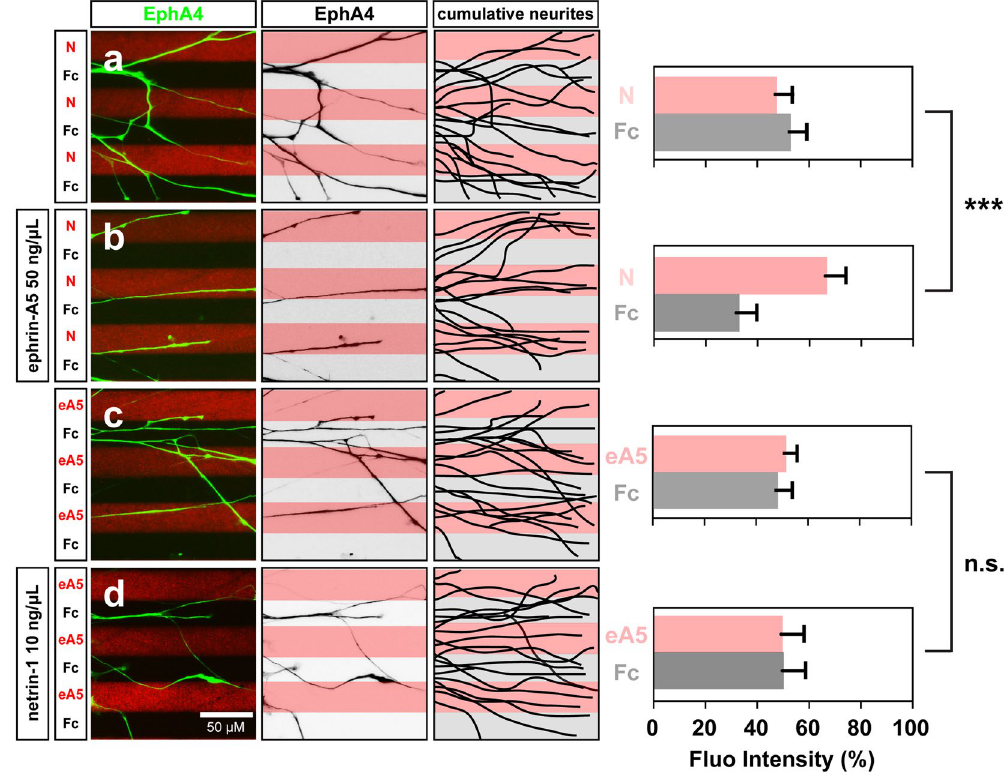
Figure 1. Lateral LMC axon growth responses to netrin-1 are sensitised by ephrin-A5. Axon outgrowth preference on protein stripes exhibited by lateral LMC axons. left panels: explanted lateral (EphA4 + ) LMC neurites on netrin-1 (N)/Fc ( a , b ) or ephrin-A5 (eA5)/Fc stripes ( c , d ) with or without bath treatment of ephrin-A5 ( b ) or netrin-1 ( d ). Middle panels: inverted images of EphA4 signals shown at left panels. Right panels: superimposed images of five explants from each experimental group representing the distribution of lateral LMC neurites. Quantification of lateral LMC neurites on first (pink) and second (pale) stripes expressed as a percentage of total EphA4 signals. Noted that no preference is detected when lateral LMC neurites are challenged with stripes of low levels of netrin-1 (10 ng/mL) or ephrin-A5 (50 ng/mL). Minimal number of neurites: 81. Minimal number of explants: 12. N, netrin-1; eA5: ephrin-A5; error bars = SD; *** P < 0.001; statistical significance computed using Mann-Whitney U